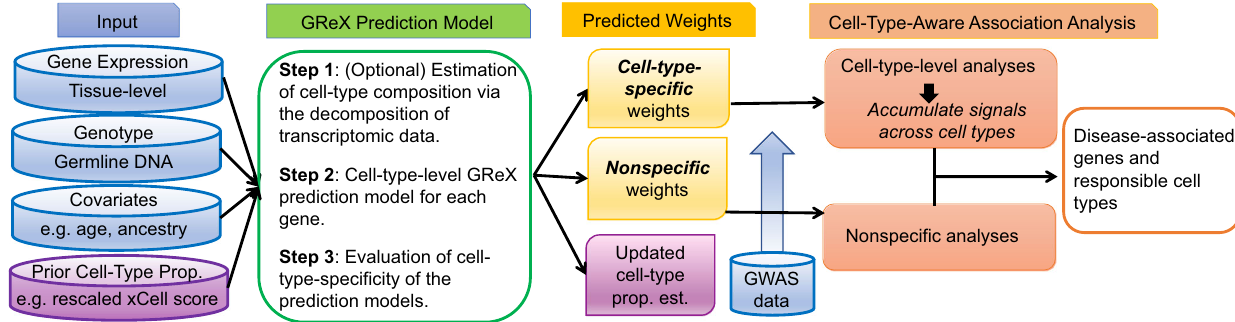
Fig. 1 | MiXcan framework. MiXcan estimates cell-type composition using transcriptomic data, builds cell-type-speci fi c and nonspeci fi c GReX prediction models, identi fi es disease-associated genes in any cell types, and provides insight into the cell type responsible for the disease